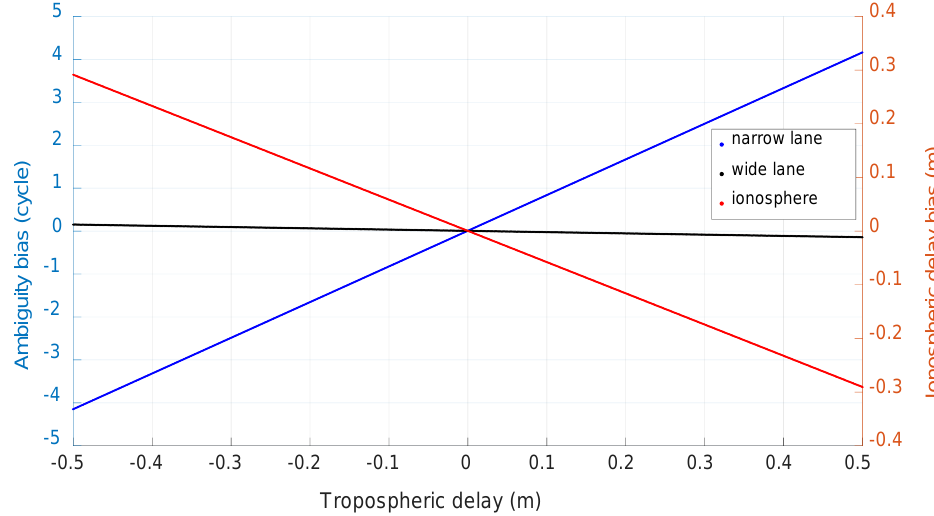
Figure 19. The caused bias of neglected tropospheric error (GPS).